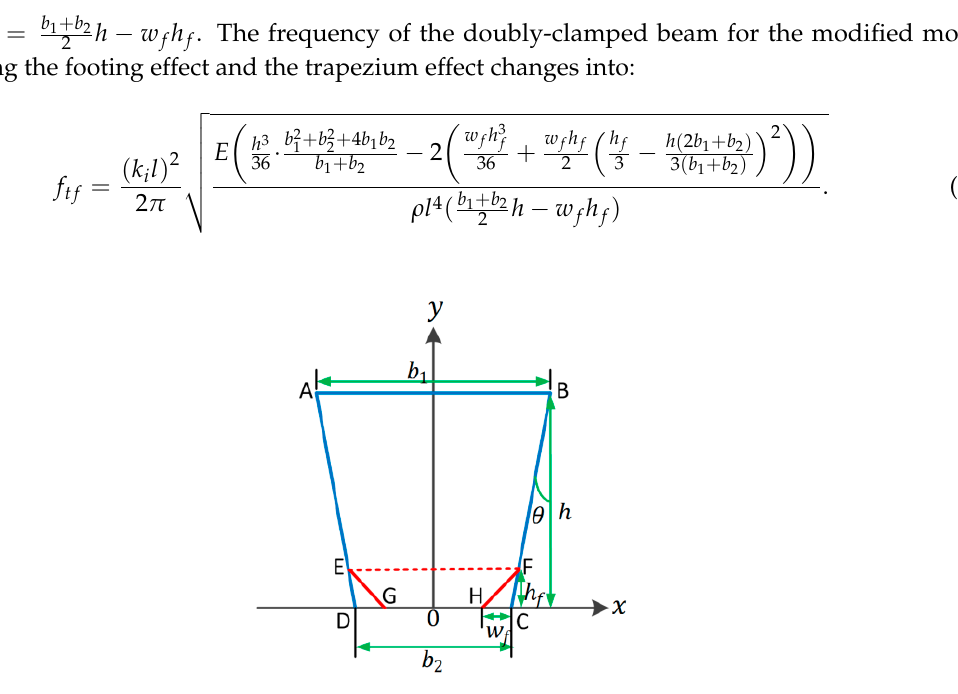
Figure B1. The coordinate sketch-map for the cross section of a doubly-clamped beam while considering the footing effect and the trapezium effect.